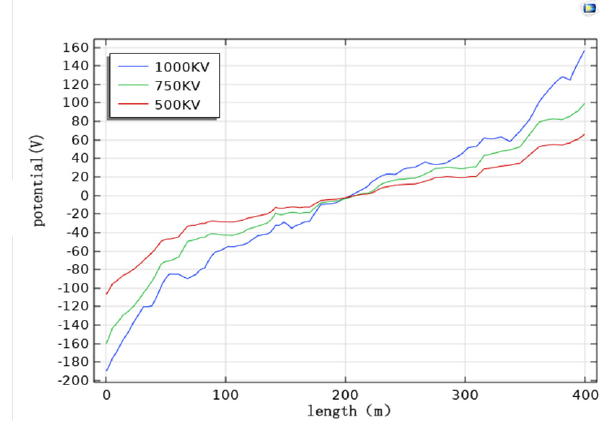
Figure 11. The influence law of transmission line voltage level on cathodic protection potential.